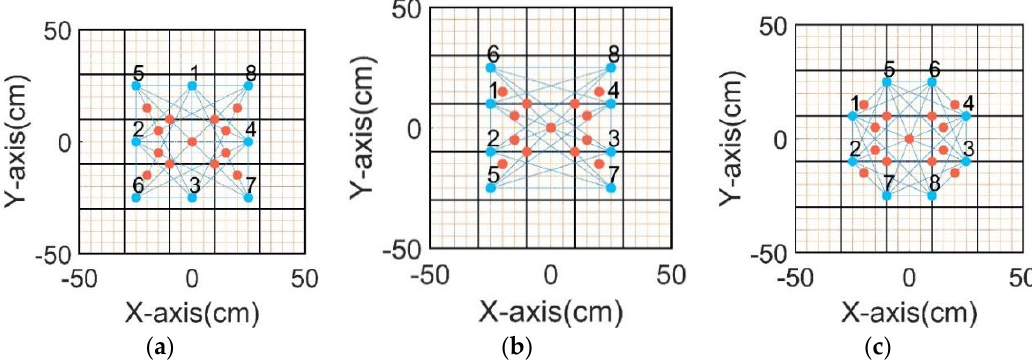
Figure 5. Schematic diagram of the experimental scheme: ( a ) type 1 sensor network; ( b ) type 2 sensor network; ( c ) type 3 sensor network. Blue dots indicate the sensor positions, red dots indicate the impact points, the black line at the edge indicates the boundary of the test piece, and the black line inside indicates positions of the stiffeners.